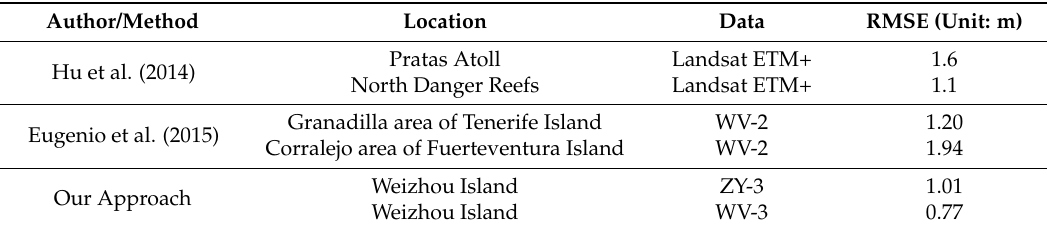
Table 5. Comparisons of the RMSEs obtained using different